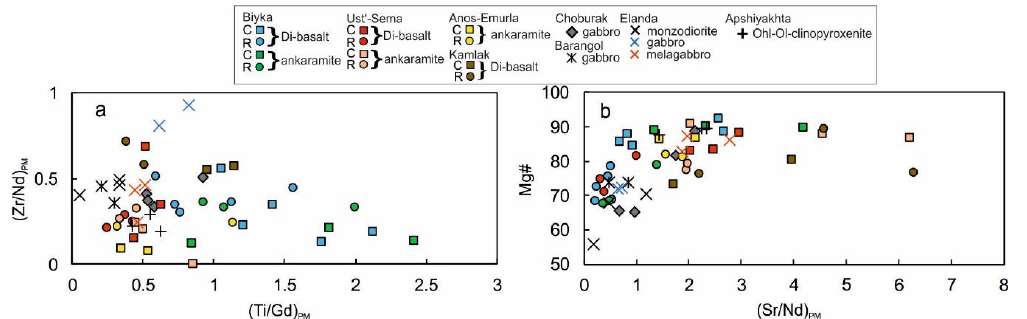
Figure 10. ( a ) (Ti/Gd) PM verses (Zr/Nd) PM ; ( b ) (Sr/Nd) PM verses Mg# for the clinopyroxenes from the rocks of the Ust’ -Sema Formation and the Barangol Complex. All ratios were normalized to the primitive mantle